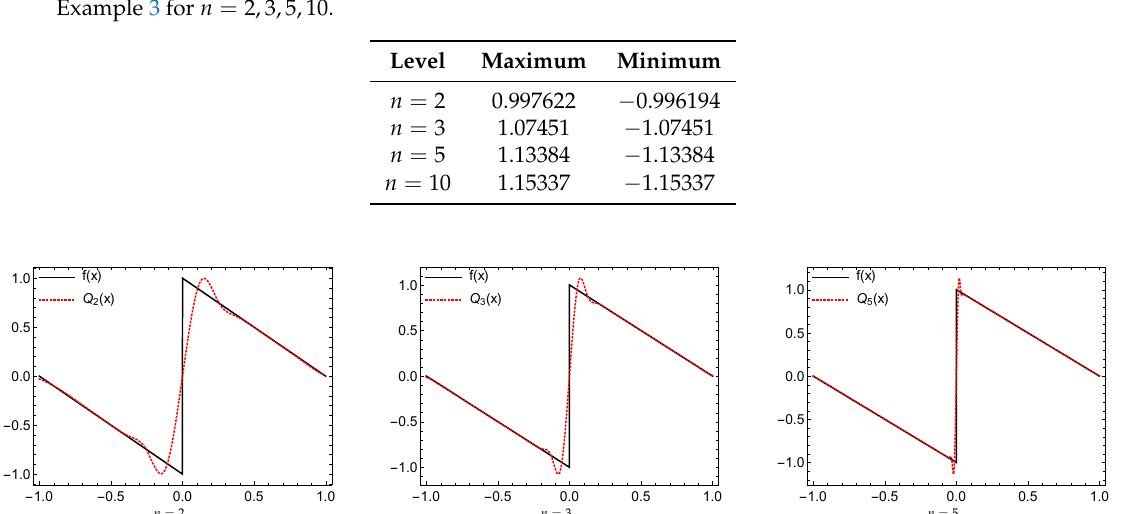
Figure 11. Illustration of the Gibbs effect using the quasi-operator Q n f of Example 2. Table 3. Approximate maximum overshoot and undershoot in neighborhoods of x = 0 using Q n f of Example 3 for n = 2,3,5,10.